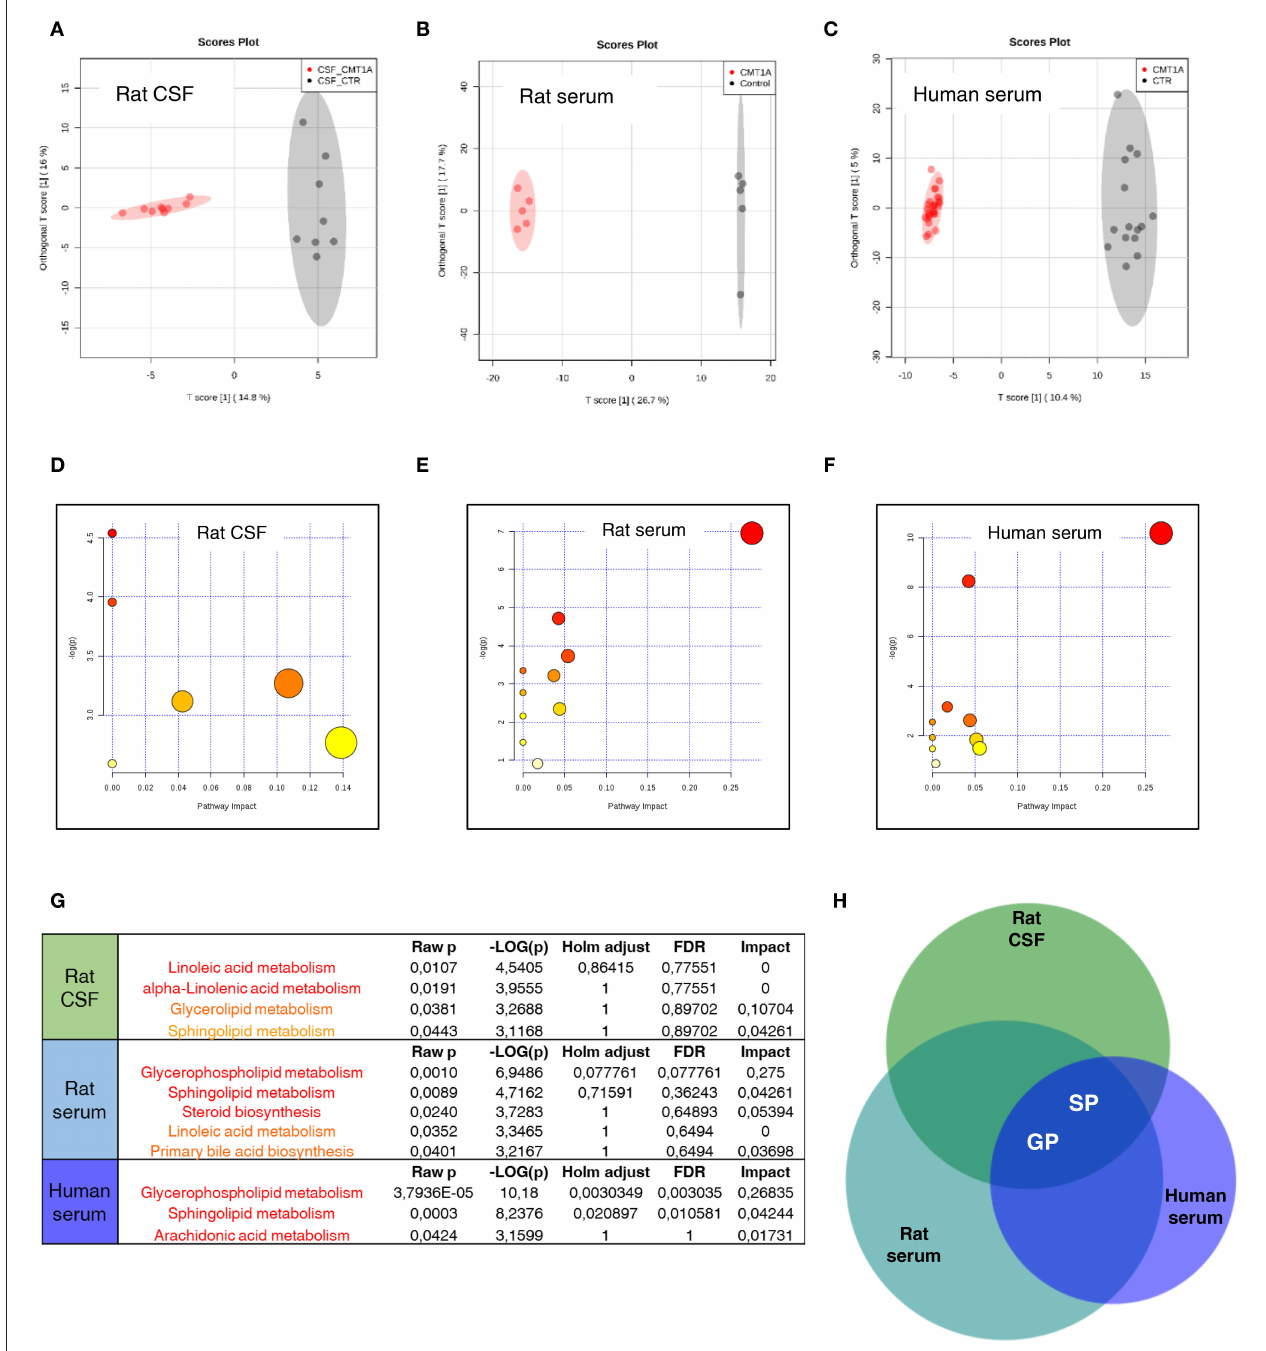
FIGURE 4 | Sphingolipid (SP) and glycerophospholipid (GP) pathways present a reliable source of CMT1A wet biomarkers. (A) Score plot from Orthogonal Projections to Latent Structures Discriminant Analysis (OPLS-DA) of untargeted lipidomics data. (A) OPLS-DA analysis was able to reliably discriminate CMT1A CSF (red, n = 9) from the wild type (WT) one (black, n = 8). (B) Corresponding OPLS-DA analysis of rat serum lipidome displayed a clear separation between the two phenotypes (WT, black, n = 5 and CMT1A, red, n = 5). (C) Untargeted lipidomics was also performed on the serum of 15 healthy donors and 28 CMT1A patients. Notably, OPLS-DA analysis demonstrated a clear clustering of the subjects into two groups according to the genotype. (D–F) Graphs presenting the probability (y-axis) and the impact (x-axis) that a pathway is responsible for the differences shown in lipidomic profiles. Each circle represents a specific lipid pathway; the circle size represents the number of hits per pathway. Red–orange–yellow–white diminishing scale represents the degree of involvement in lipidomic profiles. (G) Table indicating only significant pathways presented in the graphs. (H) A comparative pathway analysis (Venn diagram) shows that the dysregulation of SP and GP metabolism is mainly responsible for the difference between CMT1A and controls in both rat biofluids and the serum of human subjects. The diagram was designed by Biovenn online software (http:// www.biovenn.nl/).